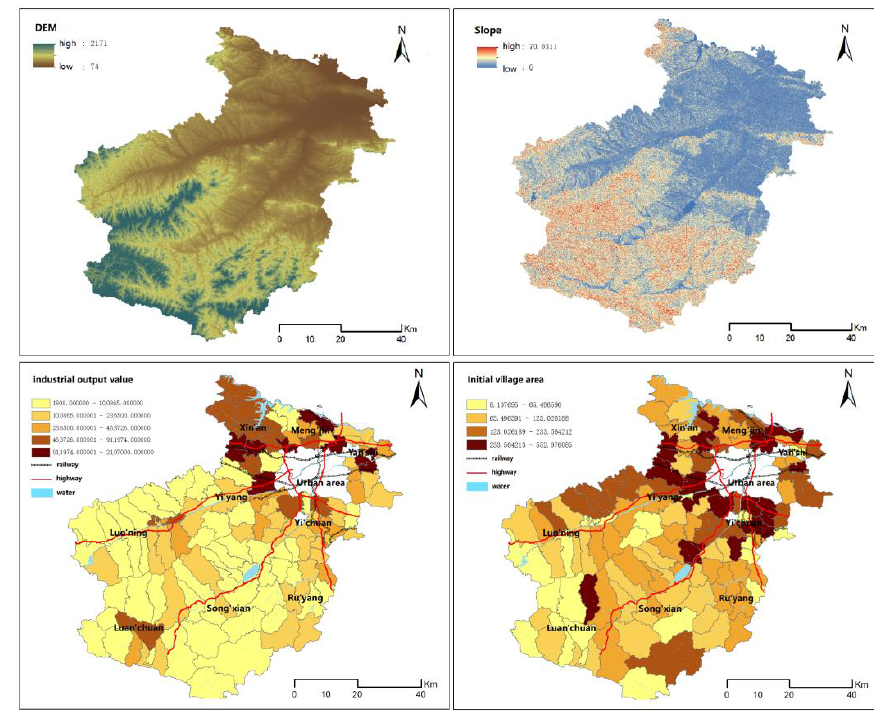
Figure 3. Spatial distribution of some driving factors.